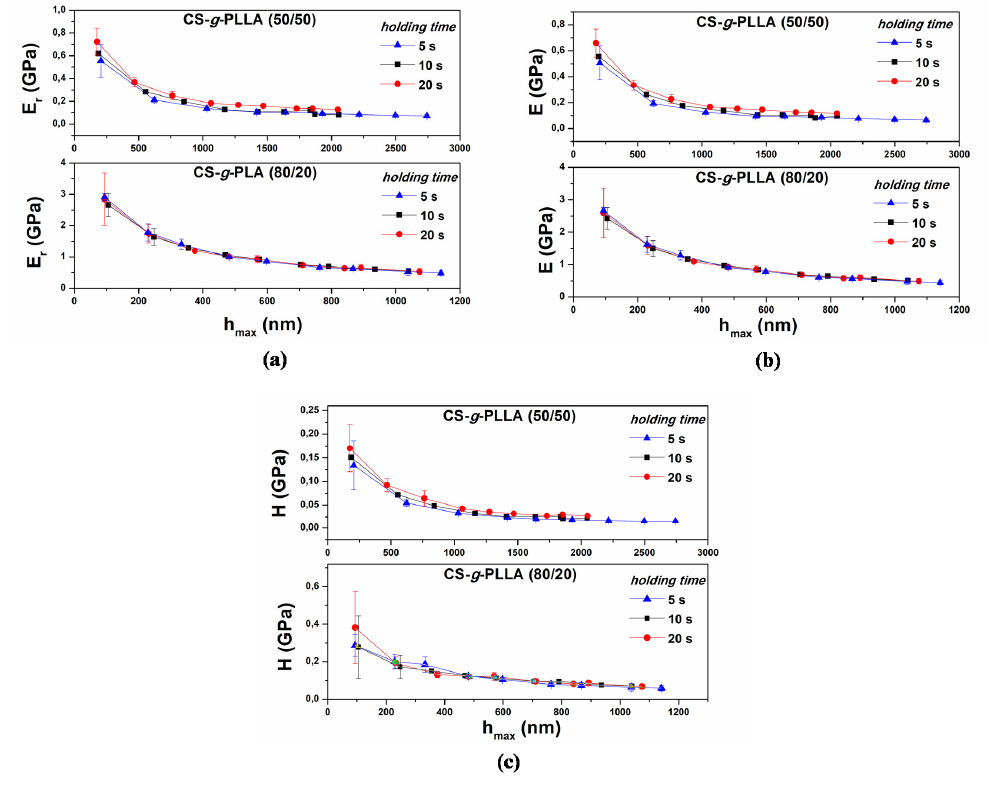
Figure 5. ( a ) Reduced modulus (Er), ( b ) Young’s modulus (E) and ( c ) hardness (H) values for the CS- g -PLLA copolymers as a function of maximum indentation depth, for 5, 10 and 20 s holding times.